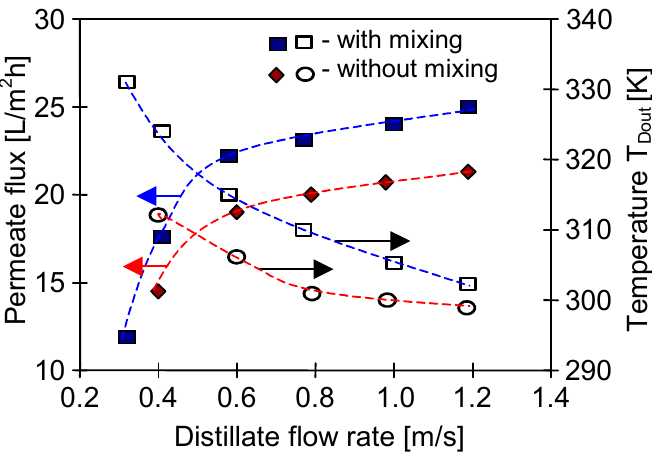
Figure 9. The influence of distillate flow rate and turbulence in the feed tank on the permeate flux and distillate outlet temperature in the presence and absence of feed mixing. Mode 1: T F = 353 K. Module SMD12 (Accurel PP S6/2, L = 120 cm).